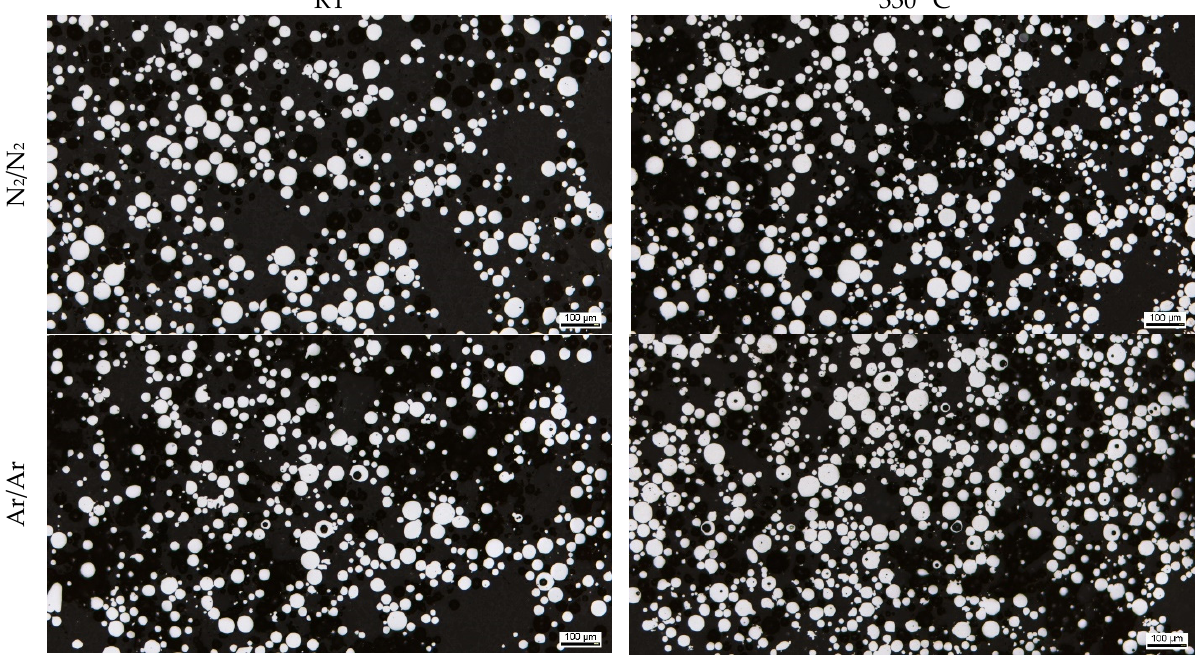
Figure 6. Light micrograph of gas-atomized X2CrNiMoCuWN25-7-4 powders (particle size 20–63 µm, polished sections).